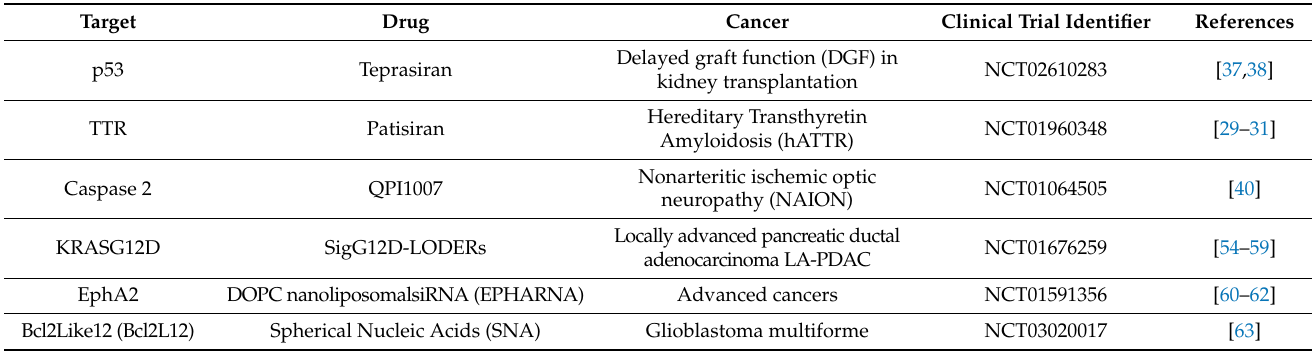
Table 2. List of siRNAs for cancer